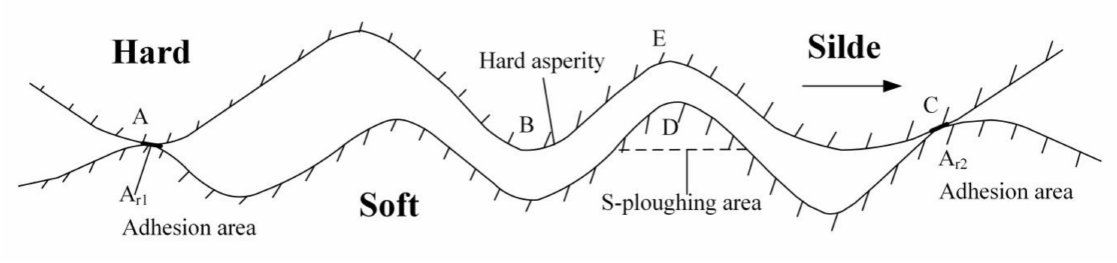
Figure 2. Adhesion and